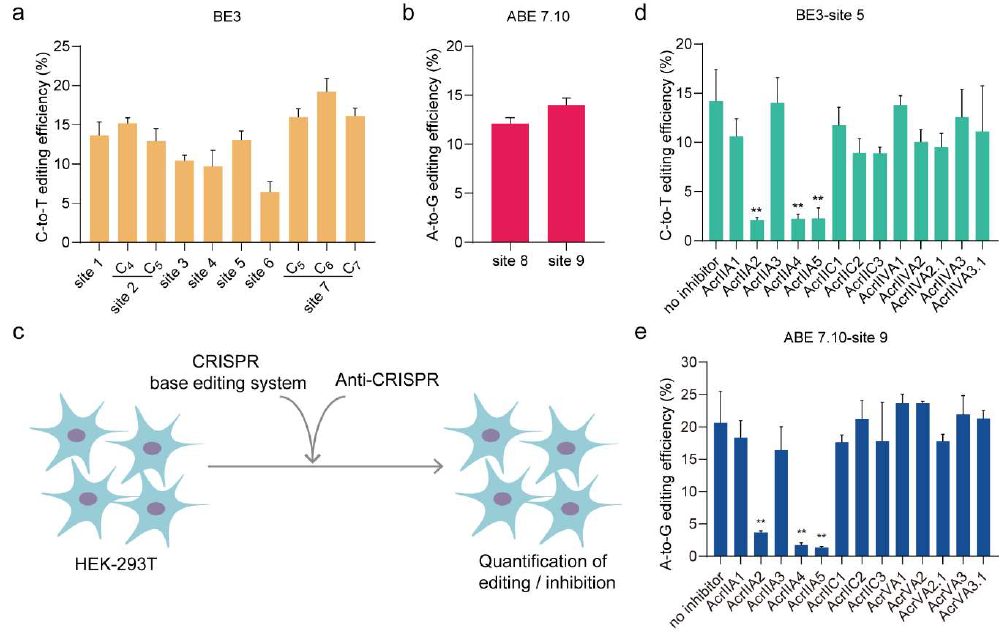
Figure 1. AcrIIA2, AcrIIA4, and AcrIIA5 inhibit BE3 and ABE7.10 in human cells. ( a )